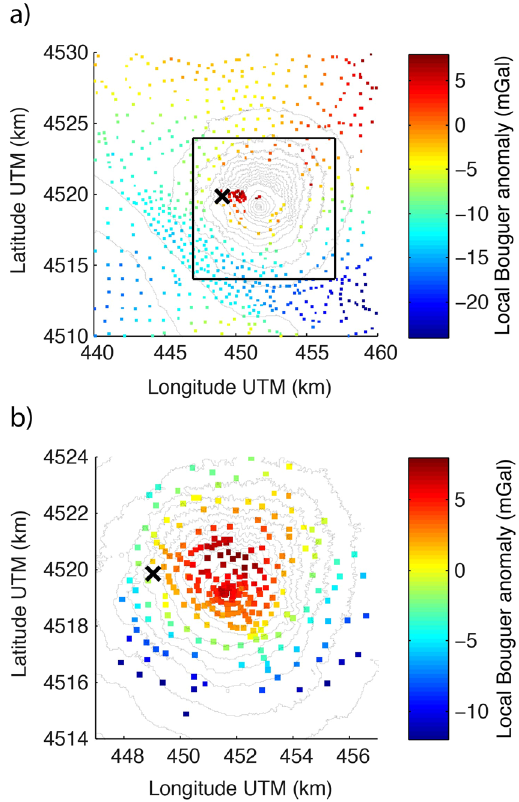
Figure 2. Local Bouguer anomaly of the ( a ) historic data and ( b ) new data set constructed using a density of 2200 kg m − 3 . The region in ( b ) is represented by a black square in ( a ). The values are given with respect to the reference station of the new data set (indicated with a × -sign). The maps were created using Matlab (version R2013b;